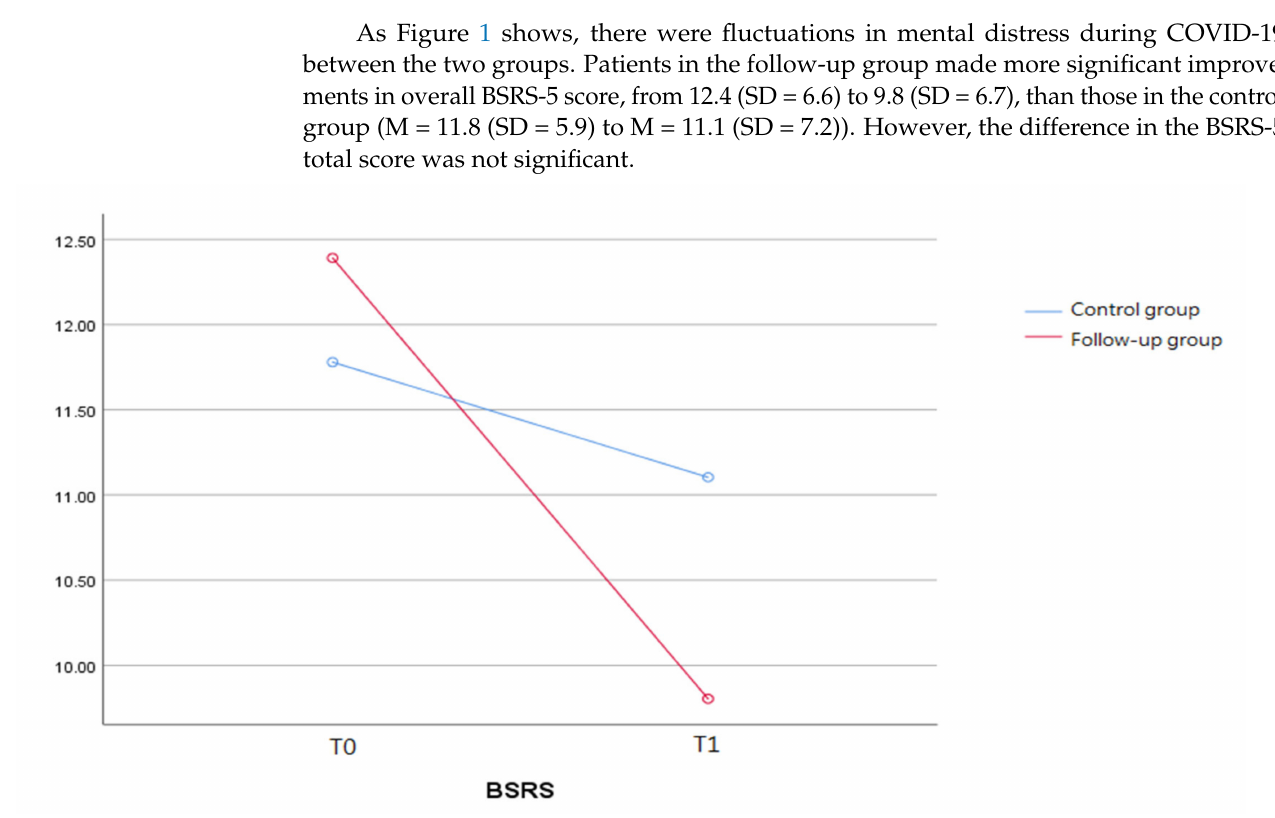
Figure 1. The fluctuations in mental distress across COVID-19 between the two